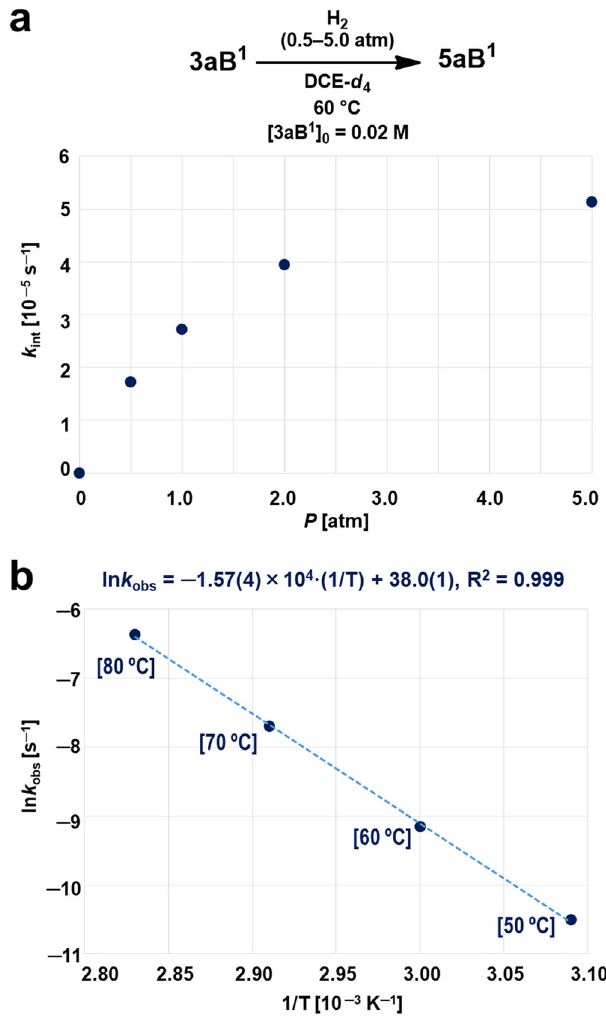
Fig. 4 Kinetic studies for the reaction between 3aB 1 and H 2 . a Plot of the H 2 pressure, P [atm], as a function of the initial reaction rate constants, k int [10 ‒ 5 s ‒ 1 ]. b Plot of 1/ T [10 ‒ 3 K ‒ 1 ] as a function of ln k obs [s ‒ 1 ]. The k obs values are the pseudo- fi rst order rate constants for the formation of 5aB 1 obtained from the reaction of 1a (2.0 × 10 ‒ 2 M in DCE- d 4 ) and H 2 (5